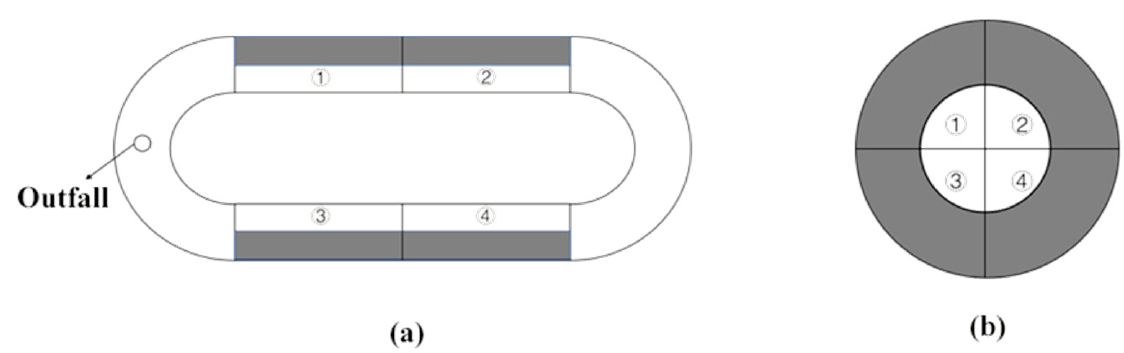
Figure 1. Different experimental devices for different development stages of Eriocheir sinensis (( a ): the experimental device of parent crabs; ( b ): the experimental devices of juvenile and button-sized crabs). The numbers 1–4 represented four experimental areas including black areas and blank areas. Four black areas represented the location of four kinds of shelters respectively.